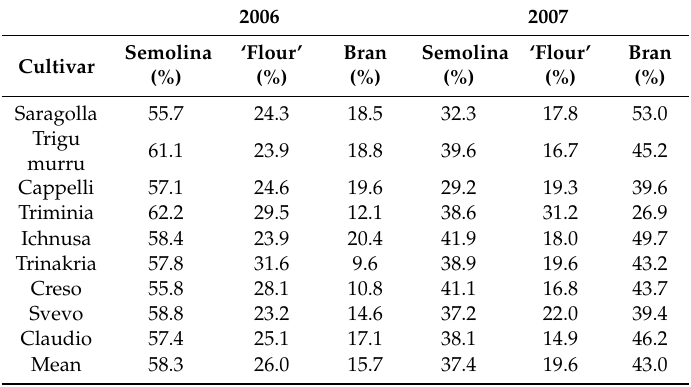
Table 4. Semolina yield.